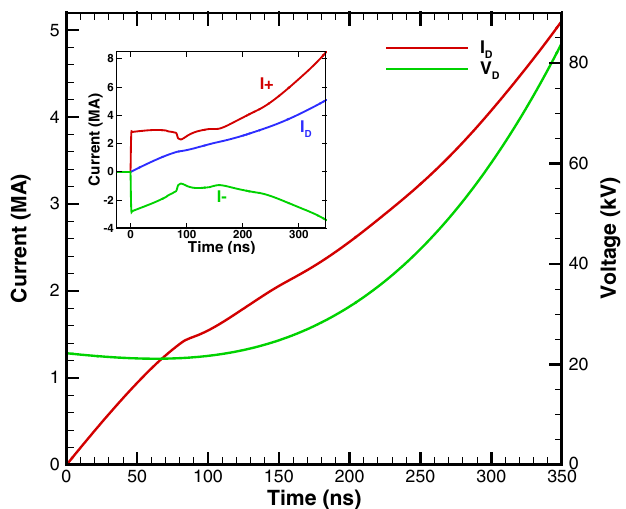
FIG. 16. Desired current and voltage for compression of copper. Inset shows decomposition of current (I) into forward- going (I þ ) and backward-going (I − )